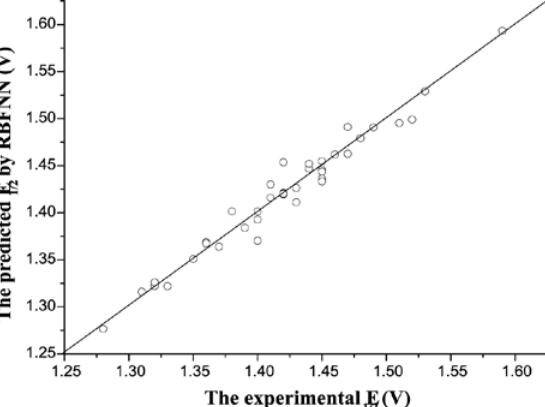
Figure 4. Experimental E